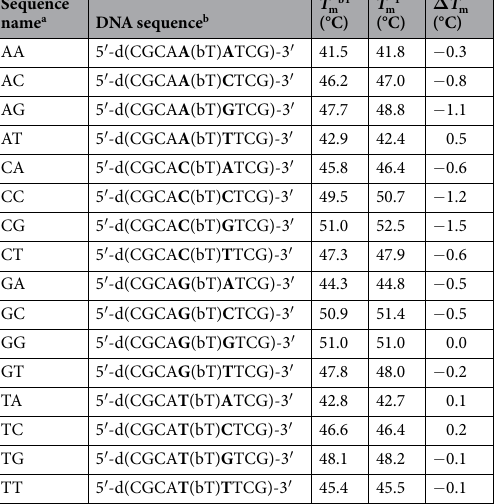
Table 2. Melting temperatures of bT-modified duplexes ( T m bT ), unmodified duplexes ( T m T ), and the difference ( Δ T m ) between them. a Sequences are named by the bases neighbouring bT on the 5 ′ - and 3 ′ -sides, respectively. b Unmodified samples contain a thymine instead of bT. Duplexes were formed by hybridization with the complementary strand as described in the experimental section. The melting temperatures were calculated as the maximum of the first derivative of the UV-melting curves, with a standard error of ≤ 0.6 °C. For individual error values, see Table S1.